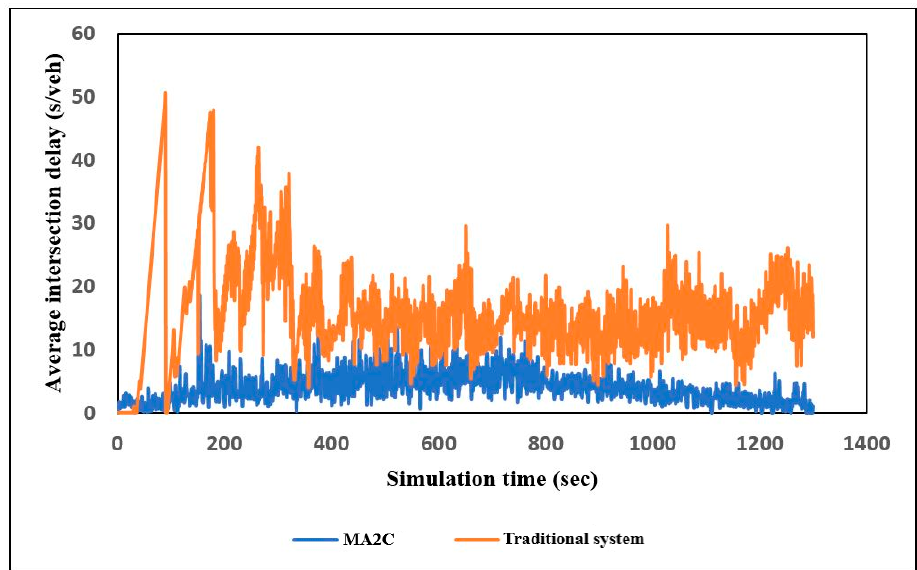
Figure 12. Average intersection delay in Shiraz traffic network.